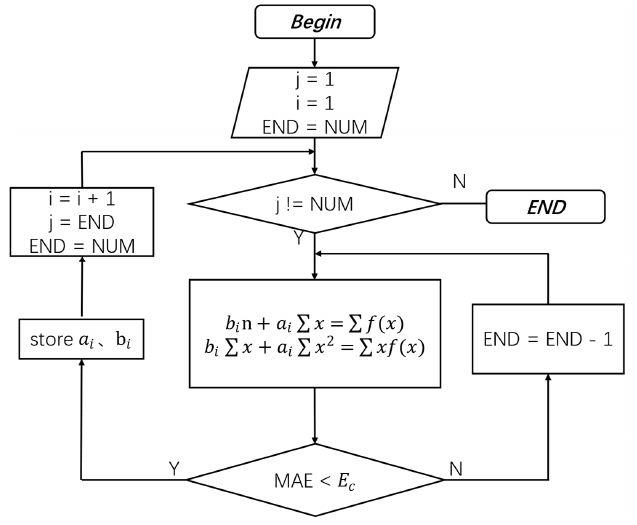
Figure 2. PWLMMAE flow